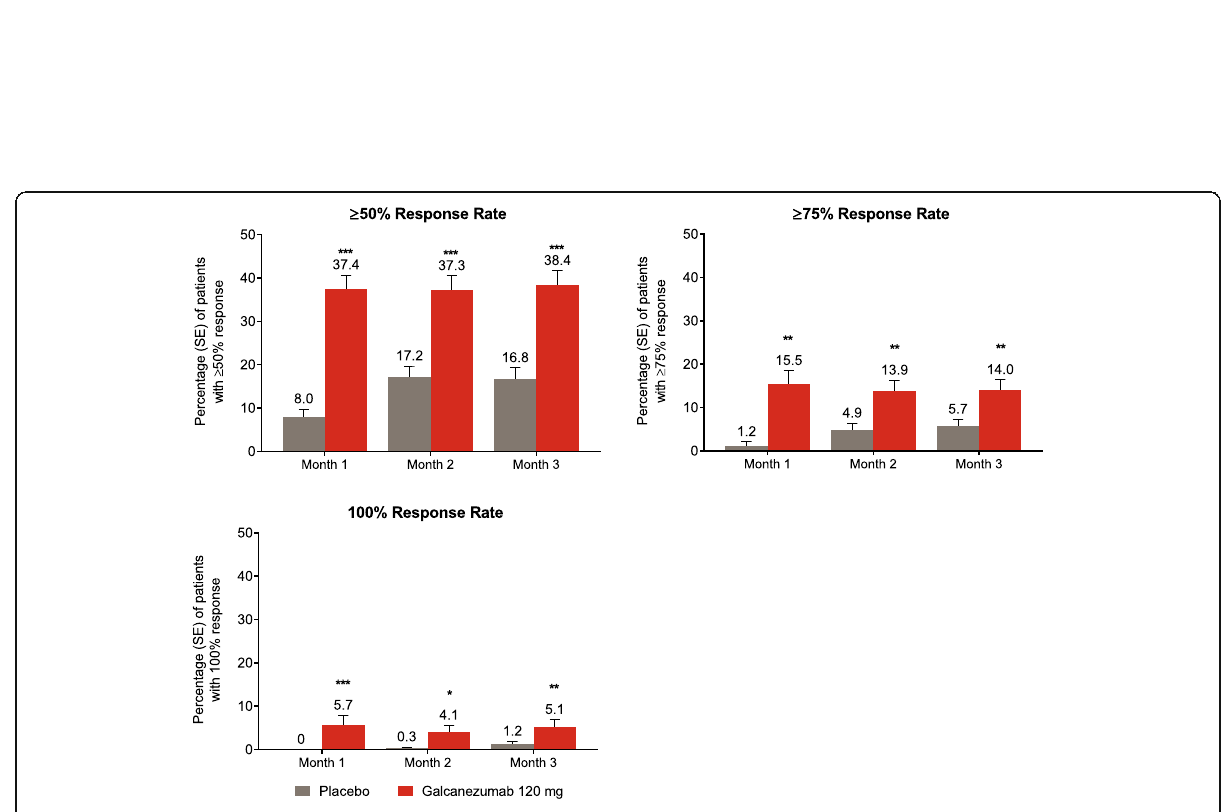
Fig. 3 Estimated proportion of patients with a migraine headache on each day of the first week after the first injection in month 1. * p < 0.05, ** p < 0.01, *** p ≤ 0.0001 vs placebo. SE standard error